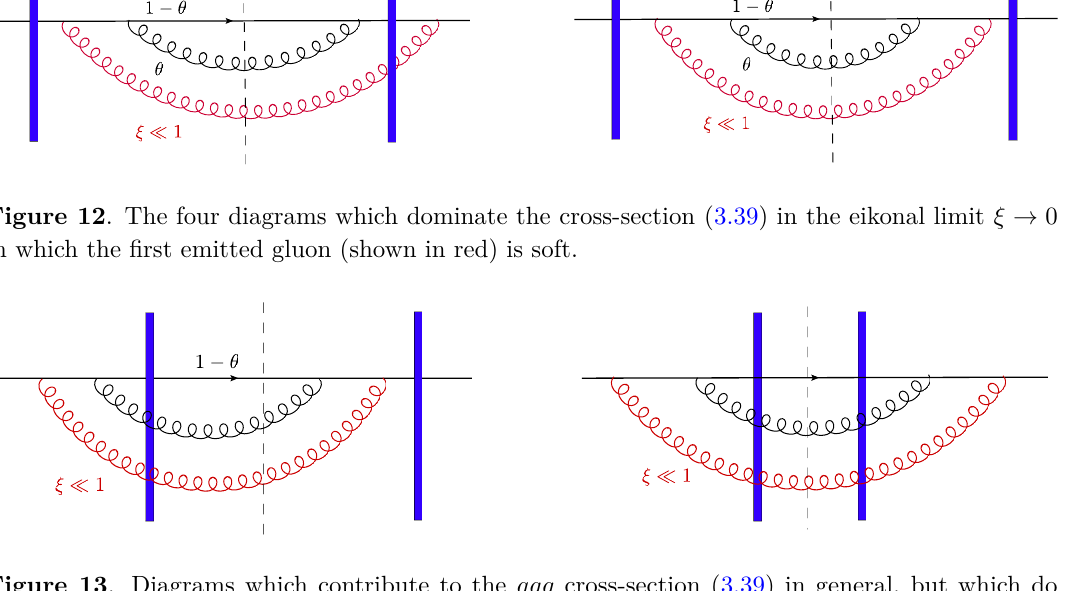
Figure 13 . Diagrams which contribute to the qgg cross-section (3.39) in general, but which do not survive in the eikonal (soft) limit for the gluon with longitudinal momentum fraction ξ (shown in red). These graphs do not contribute to the JIMWLK evolution of any of the S -matrices which enter the LO cross-section